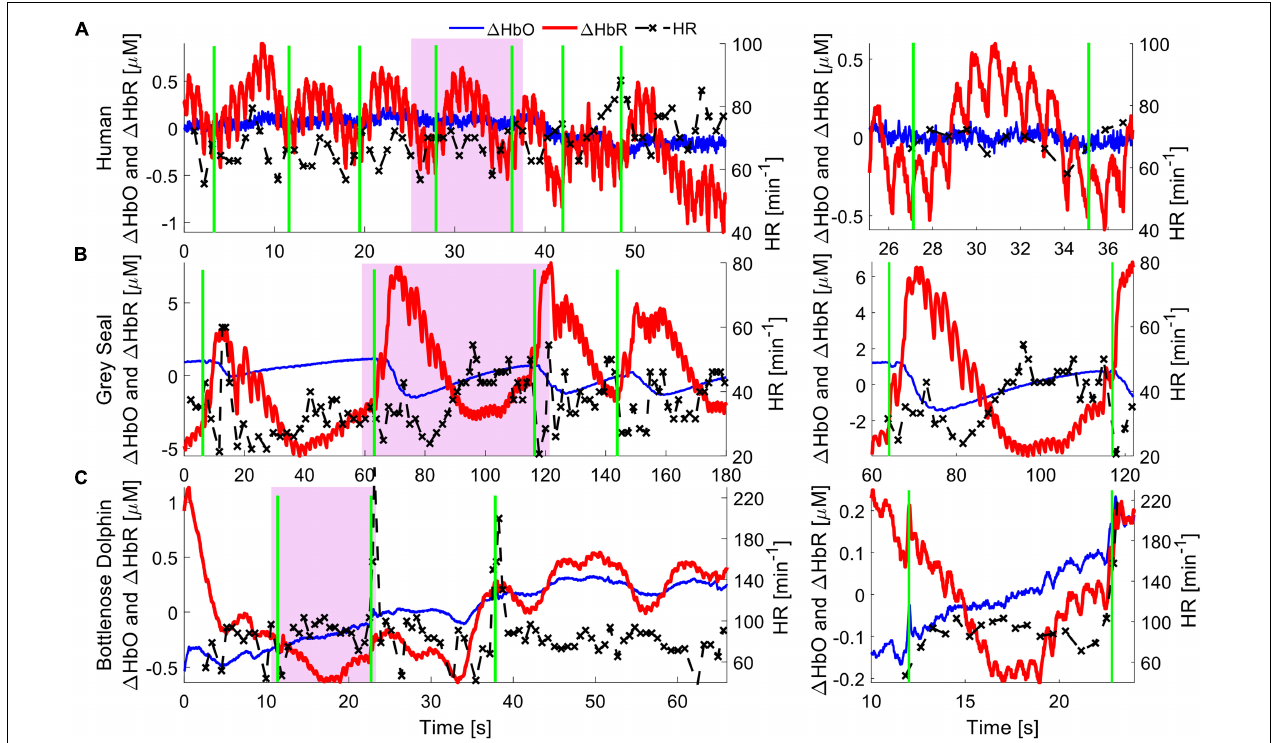
FIGURE 2 | Hemodynamics of cardiac and pulmonary activity. Hemoglobin concentration changes are demonstrated for respiration events in a human (top), gray seal (middle) and bottlenose dolphin (bottom). Oxygenated hemoglobin (red), dominantly present in arteries, shows strong cardiac pulsation. Deoxygenated hemoglobin (blue) is mostly present in capillaries and veins, and only in small concentrations in the pulsating arteries, and thus shows very little pulsation. The green vertical lines indicate manually recorded respiration onsets, be it inhalation in humans or exhalation in marine mammals. The apparent pulse-to-pulse heart rate is shown in black and reveals respiratory sinus arrythmia (RSA) in the human. The seal shows a reduction in heart rate immediately following respiration, alongside an increased hemoglobin concentration pulse amplitude. The bottlenose dolphin shows an increase in heart rate following the respiration event with a slight delay, likely due to RSA. A zoomed in image of the purple shaded areas for single respiration events is shown on the right, to emphasize the cardiac pulsation